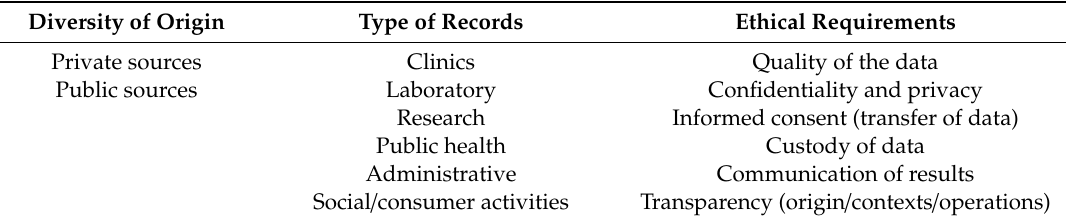
Table 1. Characteristics about the origin of the data in the big data of Health Care 1